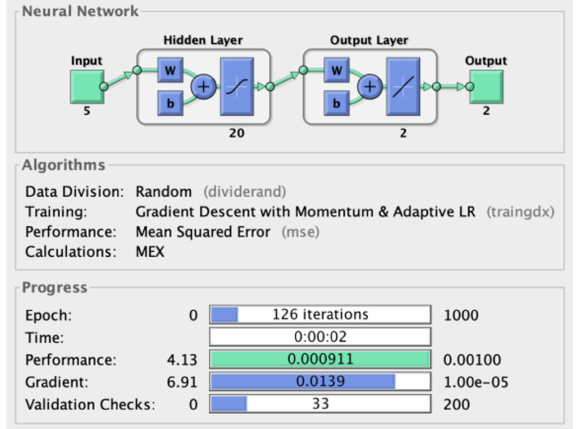
Figure 4. Parameter setting of BP-NN model.